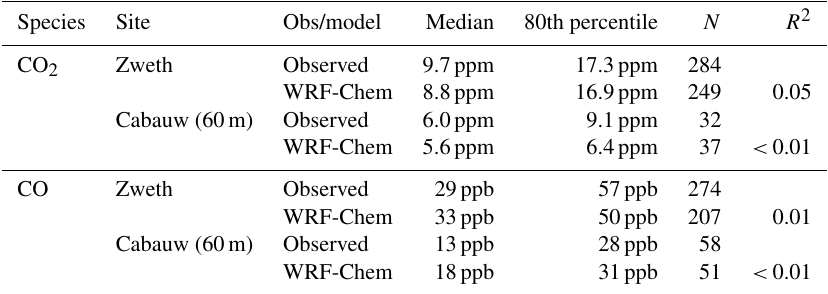
Table 4. Statistics for the distribution of the observed and modelled (WRF-Chem) urban plume mixing ratios ( (cid:49) CO 2 and (cid:49) CO) at the Zweth and Cabauw sites. N is number of hours included for either the observed or simulated time series. The R 2 in the final column is based on co- sampling of WRF-Chem with the observations. The agreement between WRF-Chem and the observations is satisfactory when considering the distribution of the plume mixing ratios, but the low explained variance when co-sampling suggests a large impact of transport errors on individual